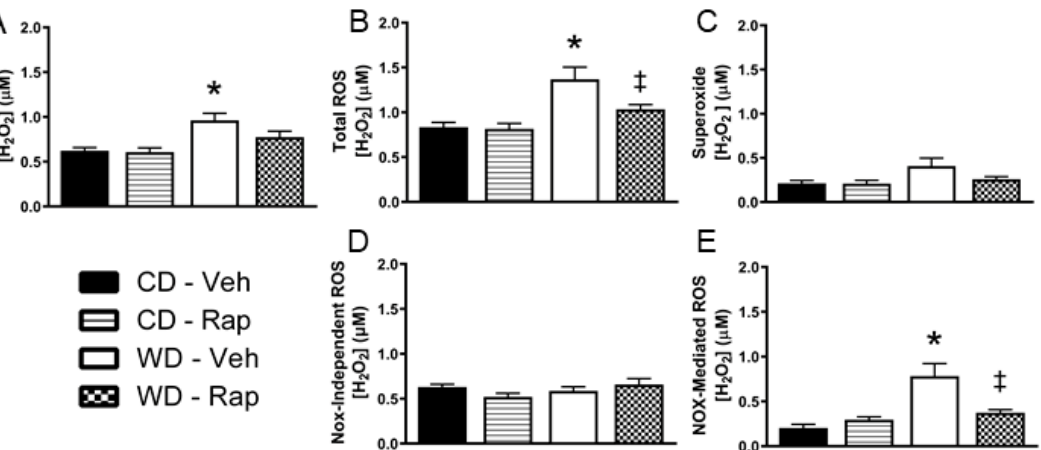
Figure 3. Assessment of in vivo penile reactive oxygen species (ROS) by microdialysis. Mice were fed the control (CD) or Western (WD) diet and treated with vehicle or 2 mg/kg rapamycin (Rap). ( A ) ROS were measured without superoxide dismutase (SOD) in the perfusate, indicative of H 2 O 2 produced endogenously. ( B ) ROS were measured with SOD added to the perfusate, which is indicative of endogenous superoxide detected in addition to H 2 O 2 (total ROS). ( C ) The H 2 O 2 only signal was subtracted from the total ROS signal, reflecting the contribution of superoxide to the ROS measurement. ( D ) Total ROS were measured with the NADPH oxidase (Nox) inhibitor apocynin added to the perfusate. Nox-independent ROS were measured as the total ROS signal that was not inhibited by apocynin. ( E ) Nox-mediated ROS were determined by calculation of the ROS that was inhibited by apocynin. Data are presented as mean ± standard error of the mean for n = 9–10 mice per group; * p < 0.05 vs. CD-Veh, ‡ p < 0.05 vs. WD-Veh.